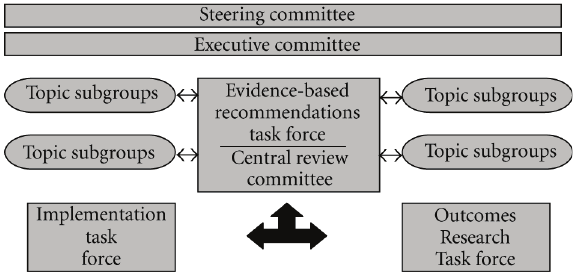
Figure 1: Organization of the Canadian Hypertension Education